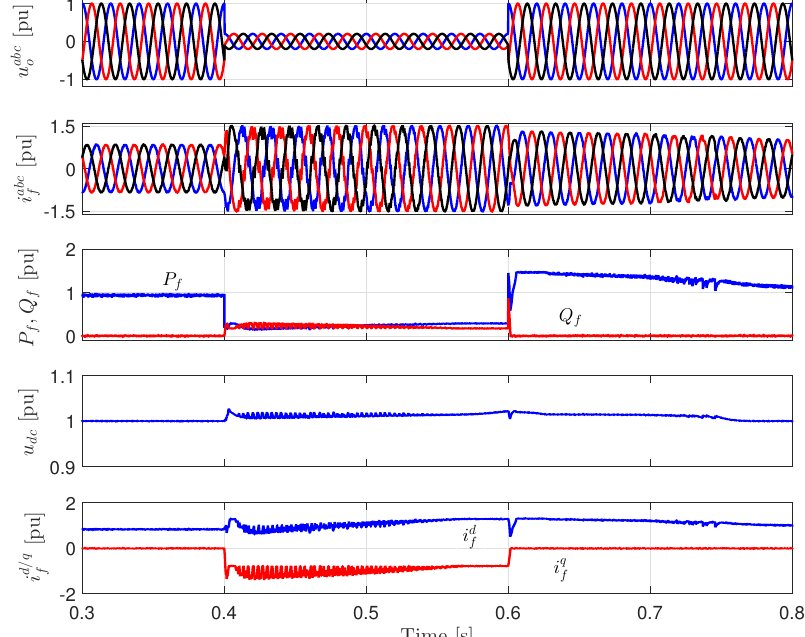
= ( i a ) (cid:62) , , i b , i c f f f f